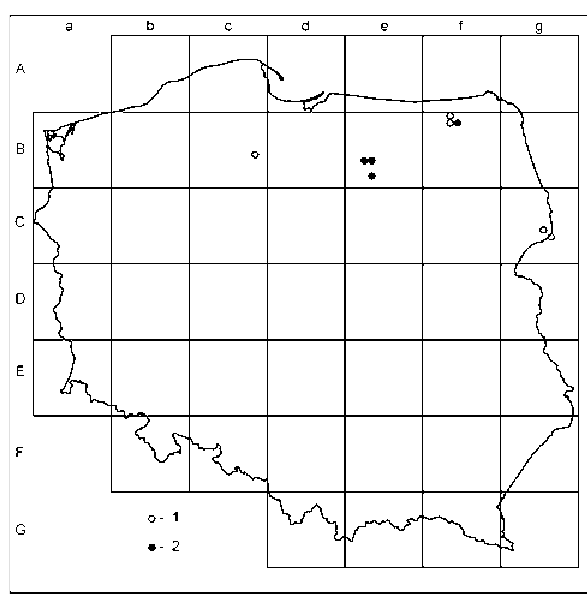
Fig. 2. Distribution of Caloplaca lucifuga in Poland (in the ATPOL square grid): 1 – known records; 2 – new